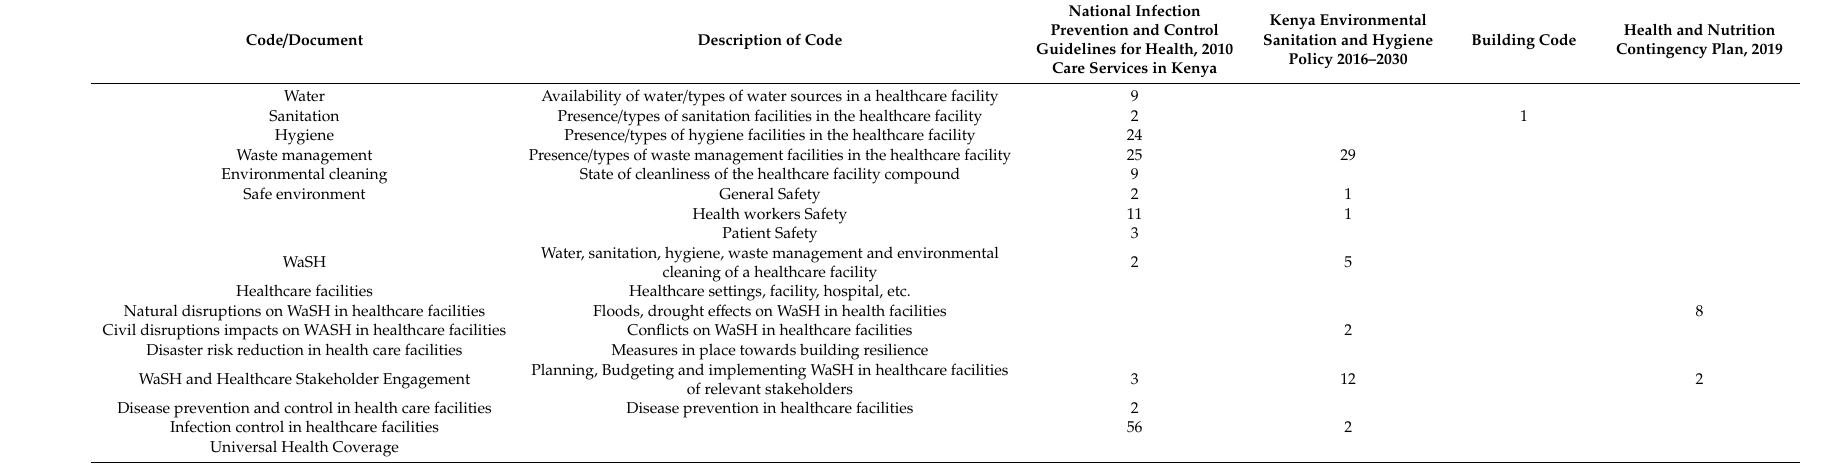
Table 5. Filled coding schedule for national-level documents